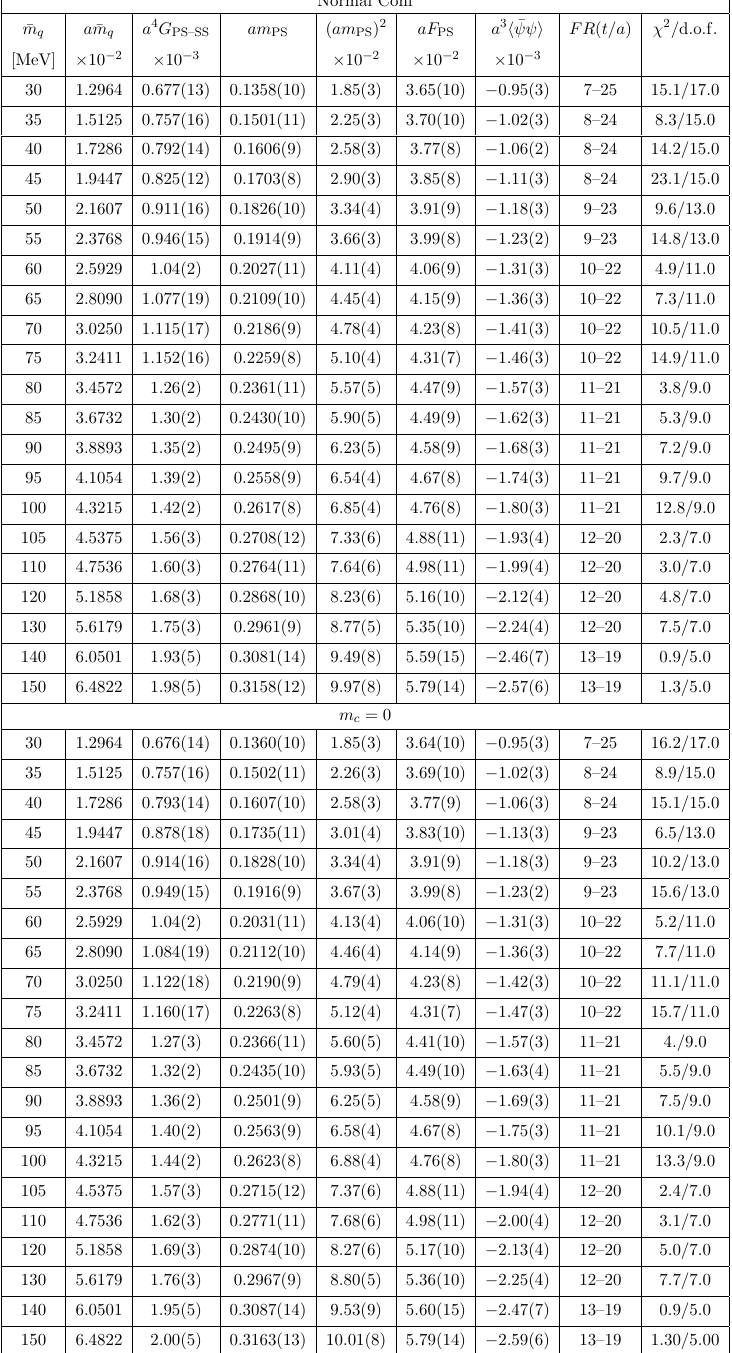
Table 24 . The (cid:12)tting results of a 4 G PS{SS and am PS together with the analytic results of the square of the pseudoscalar mass ( am PS ) 2 , decay constant aF PS , and chiral condensate a 3 h (cid:22) i . The con(cid:12)gurations are the normal con(cid:12)guration and the con(cid:12)guration of m c = 0.